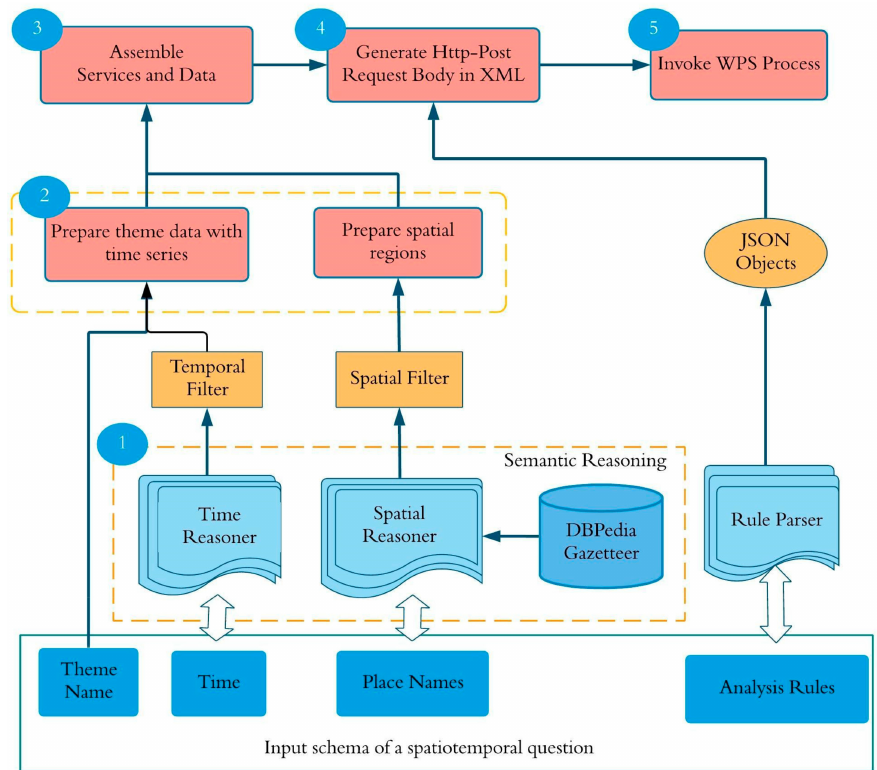
Figure 10. The workflow of the automated service chaining engine and question answering.